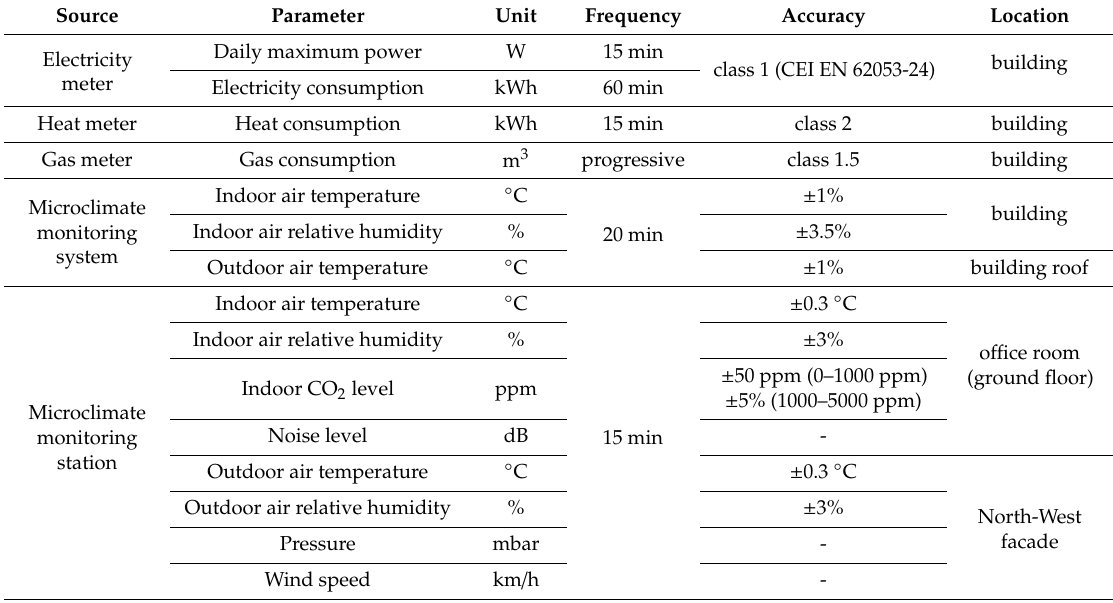
Table 1. Environmental and energy performance parameters monitored in the case study